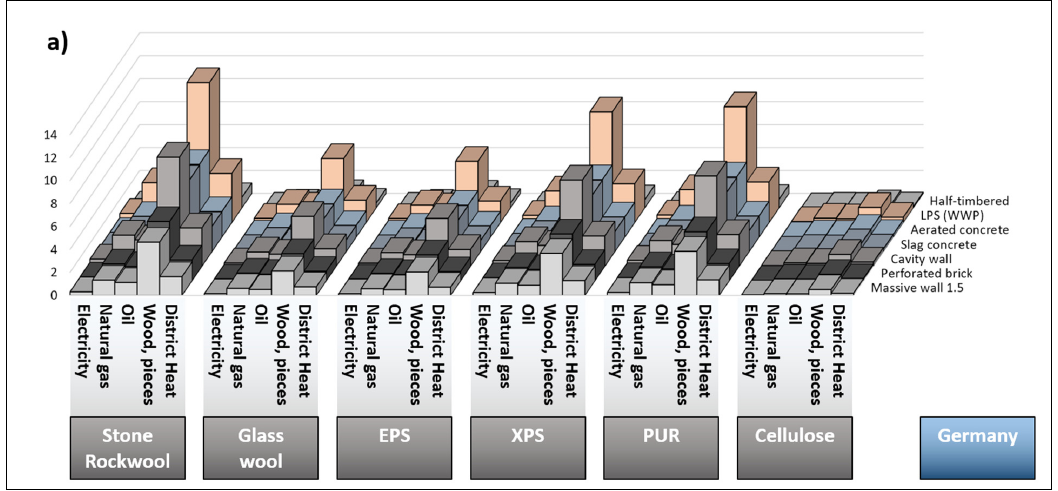
Table 8. ( a ) Average CPP values for different energy sources. ( b ) Average CPP values for various insulation